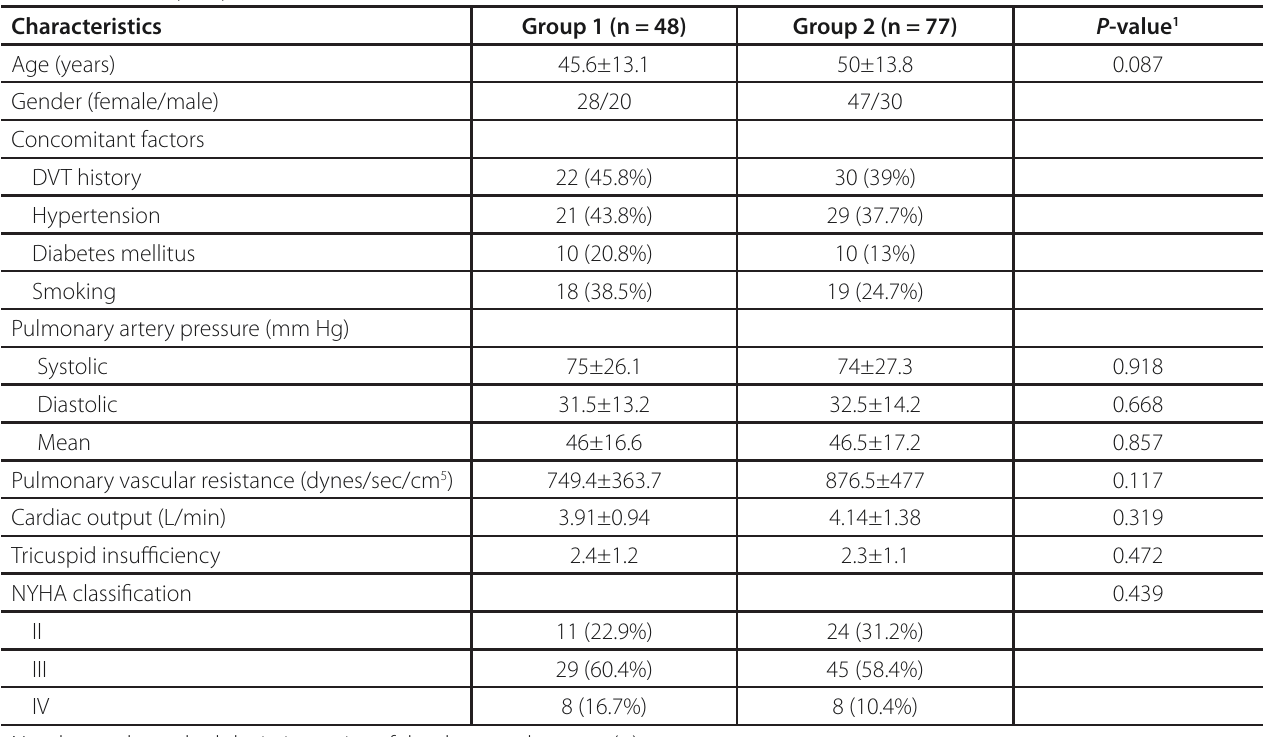
Table 1. Patients’ preoperative characteristics.